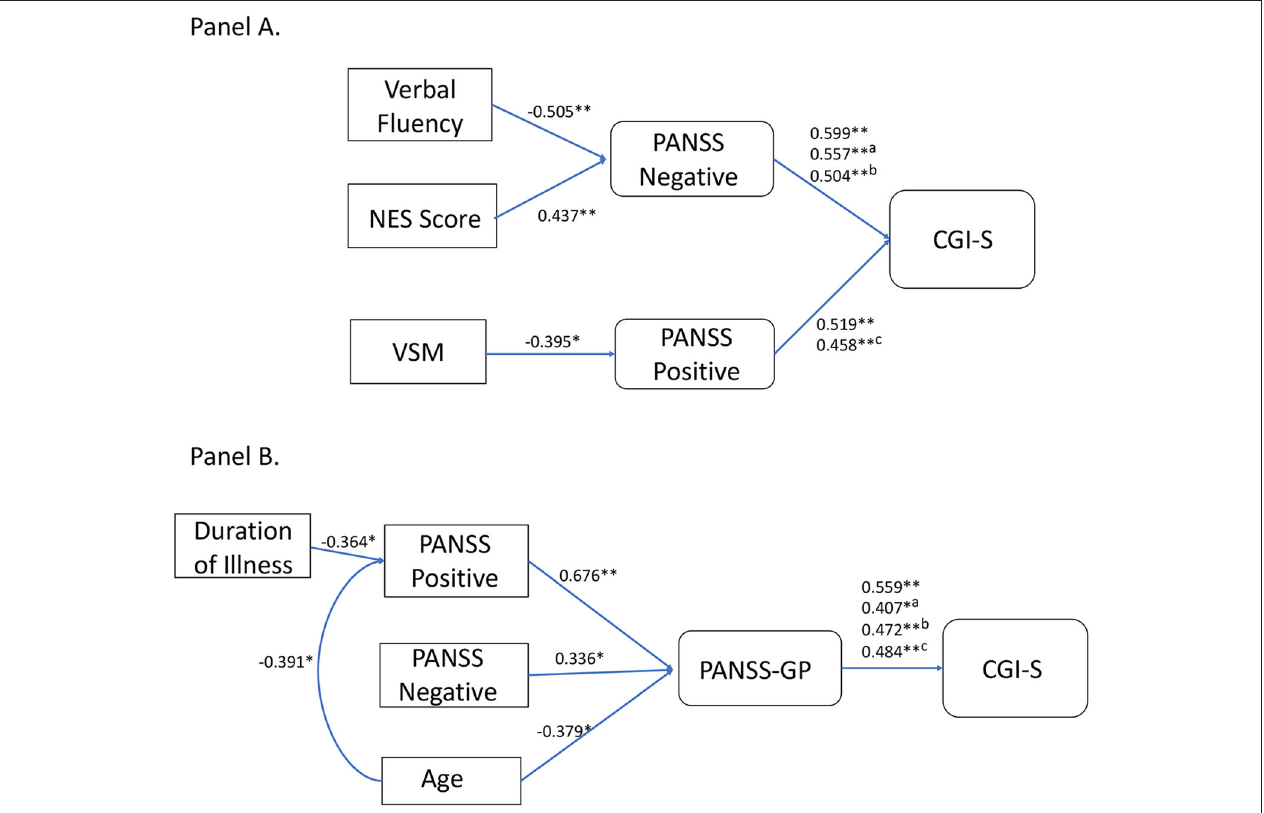
FIGURE 2 | Graphical rendering of mediation analysis. Panel (A) reports outputs of mediation analysis for the TRS group. Causal variable is on the left and outcome variable on the right. Significantly associated variables are linked by connection lines. Above connection lines are reported standardized beta values from linear regression analyses, along with p values (* p < 0.05; ** p < .005). For PANSS Negative connection with CGI-S, we reported uncontrolled, Verbal Fluency controlled (a), and NES controlled (b) standardized betas. Verbal Fluency and NES score were significantly predictive of CGI-S (standardized B = − 0.34, p = 0.03; standardized B = 0.438, p = 0.005, respectively), but significance was lost after controlling for PANSS Negative (standardized B = − 0.06, p > 0.05; standardized B = 0.218, p > 0.05). For PANSS Positive connection with CGI-s, we reported uncontrolled and VSM controlled (c) standardized betas. VSM was significantly predictive of CGI-S (standardized B = − 0.334, p = 0.03), however significance was lost after controlling for PANSS Positive (standardized B = − 0.153, p > 0.05). Panel (B) reports outputs of mediation analysis for the non-TRS group. For PANSS General Psychopathology (GP) connection with CGI-S, we reported uncontrolled, PANSS Positive controlled (a), PANSS Negative controlled (b), and age controlled (c) standardized betas. PANSS Positive, PANSS Negative, age, and duration of illness were significantly predictive of CGI-S (standardized B = 0.500, p = 0.004; standardized B = 0.417, p = 0.02; standardized B = − 0.382, p = 0.03; standardized B = − 0.362, p = 0.04, respectively), but significance was lost after controlling for PANSS-GP (standardized B = 0.225, p > 0.05; standardized B = 0.258, p > 0.05; standardized B = − 0.198, p > 0.05, respectively) or PANSS Positive in the case of duration of illness (standardized B = − 0.196, p >